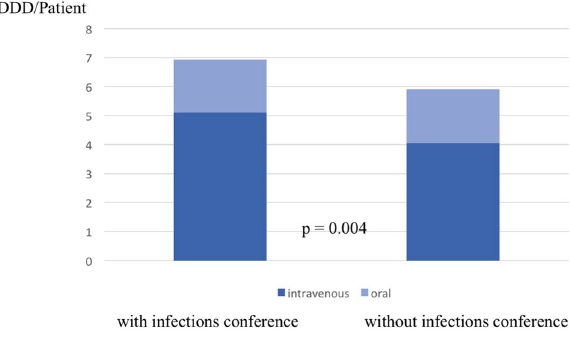
Figure 1. Defined Daily Dose per patient in both groups and subcategorization according to the application method. Number of patients included: 96 (without infections conference), 203 (with infections